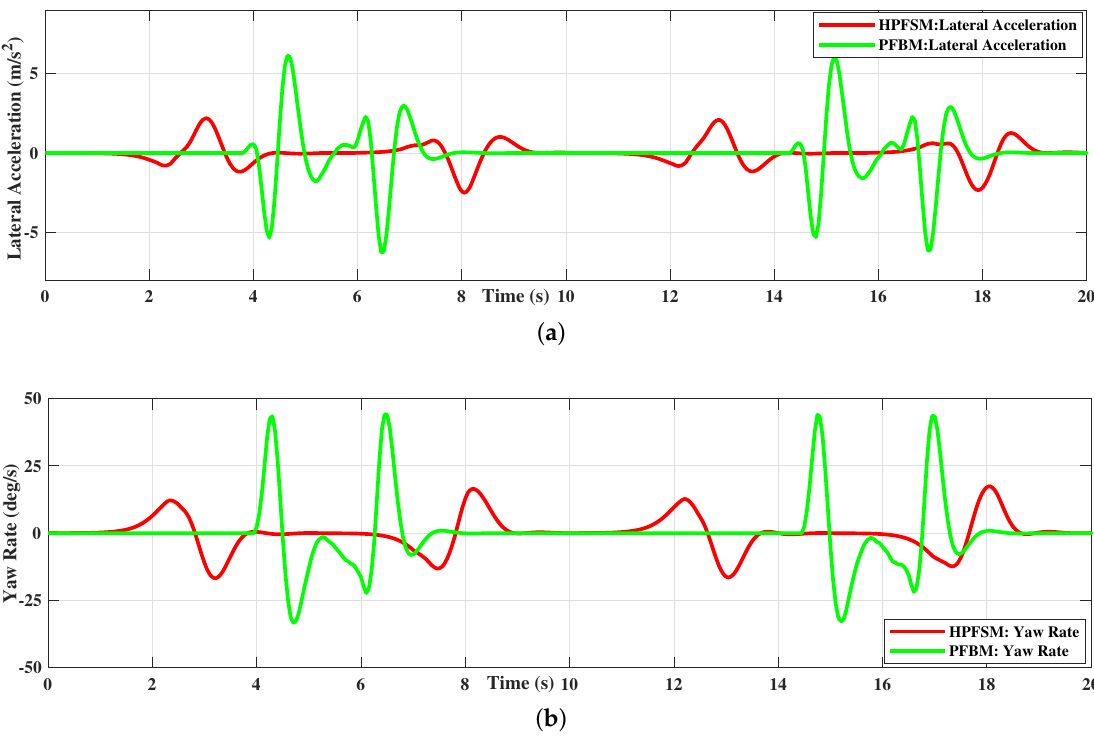
Figure 15. Path tracking comparisons between the two methods in a static scenario: ( a ) LTV-MPC tracking: Lateral acceleration comparison; ( b ) LTV-MPC tracking: Yaw rate comparison.